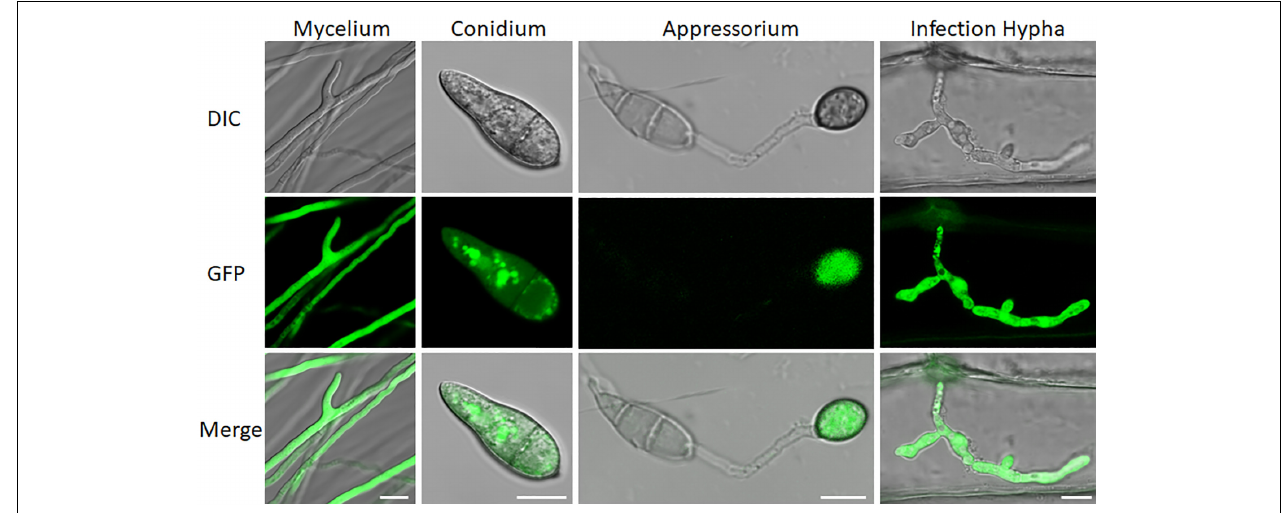
FIGURE 2 | Subcellular localization of URM1 at different developmental stages of M. oryzae . Bar, 10 µ